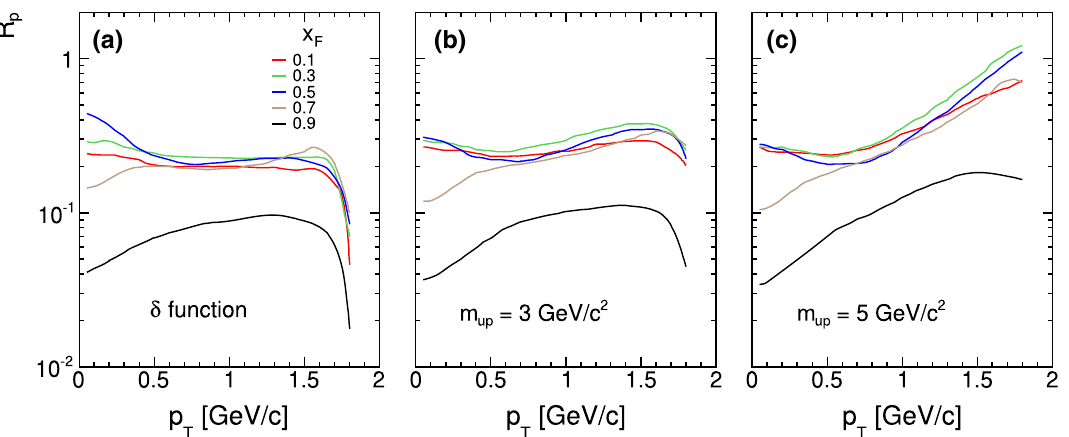
Fig. 171 Yield ratio R p = f p (Δ ++ )/ f incl ( p ) as a function of p T for x F from 0.1 to 0.9, a mass delta function, b m up = 3.0 GeV/c 2 and c m up = 5.0 GeV/c 2 Fig. 172 Mean transverse momentum as a function of x F , (a) for the decay pions and (b) for the decay protons from the Δ ++ ( 1232 )